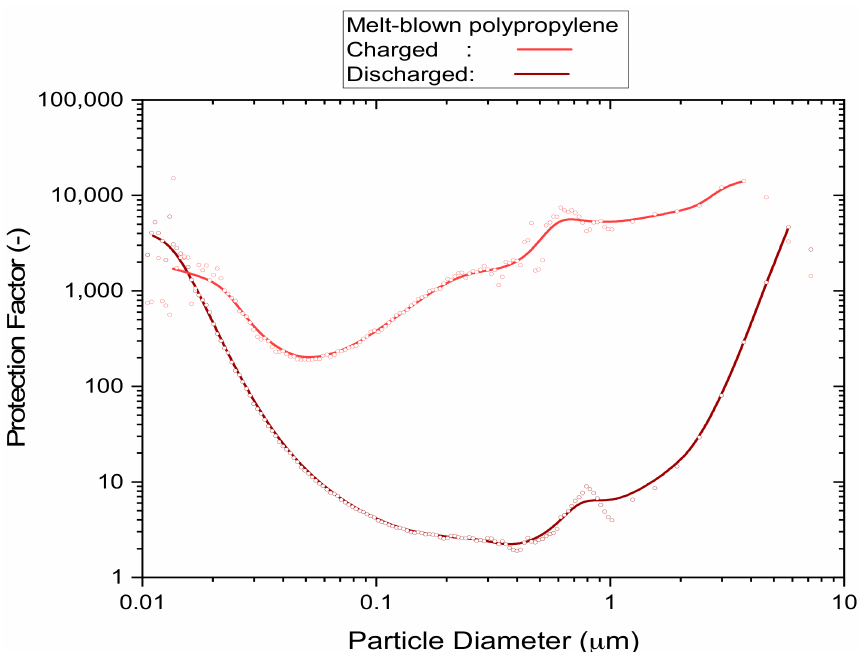
Figure 1. An example of the particle size dependence of the protection factor of uncharged and electrostatically charged filter media. Details of the P2 mask samples and method of test used to acquire the underlying data are described in Section